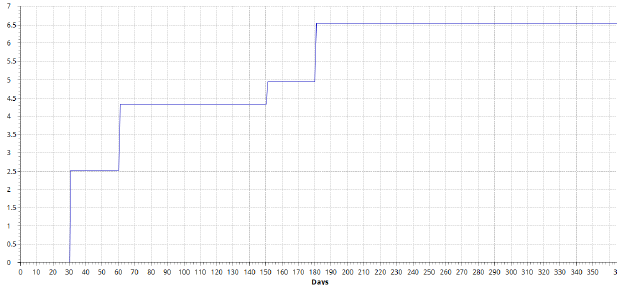
Figure 25. Lead-Time of Scenario II